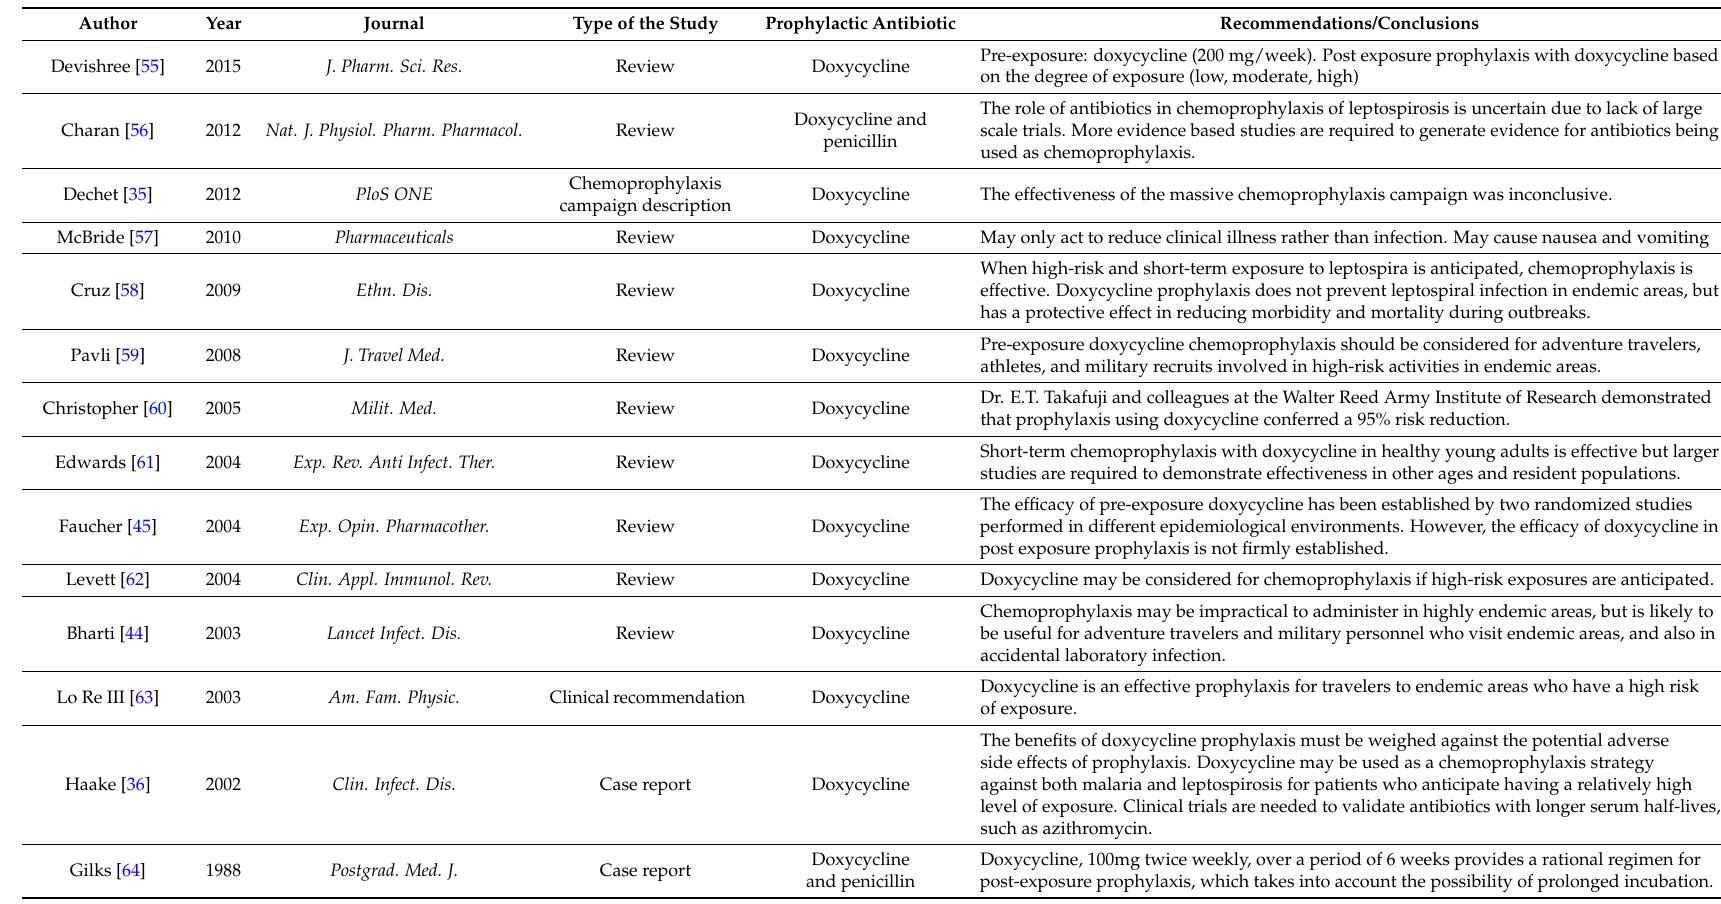
Table A2. Other publications on the effectiveness of chemoprophylaxis for